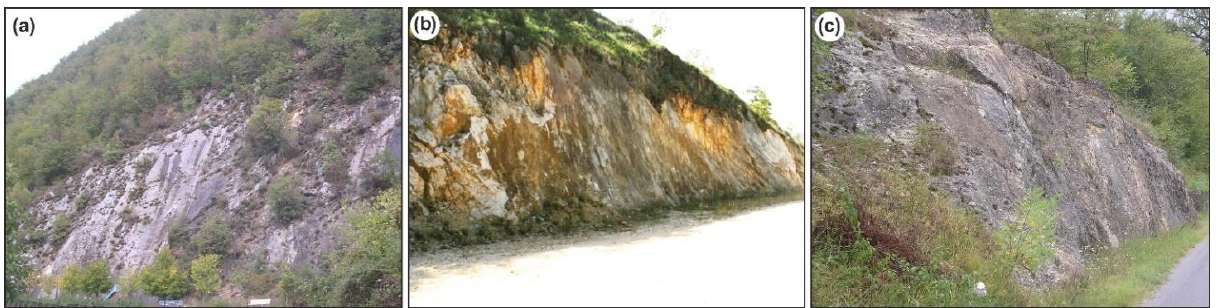
Figure 6. ( a ) NNW-SSE-oriented fault plane, located immediately above Ascrea village; ( b ) NNW-SSE-oriented fault plane, near Rocca Sinibalda village; ( c ) E-W-oriented fault plane, belonging to the Rieti Plain boundary fault system.